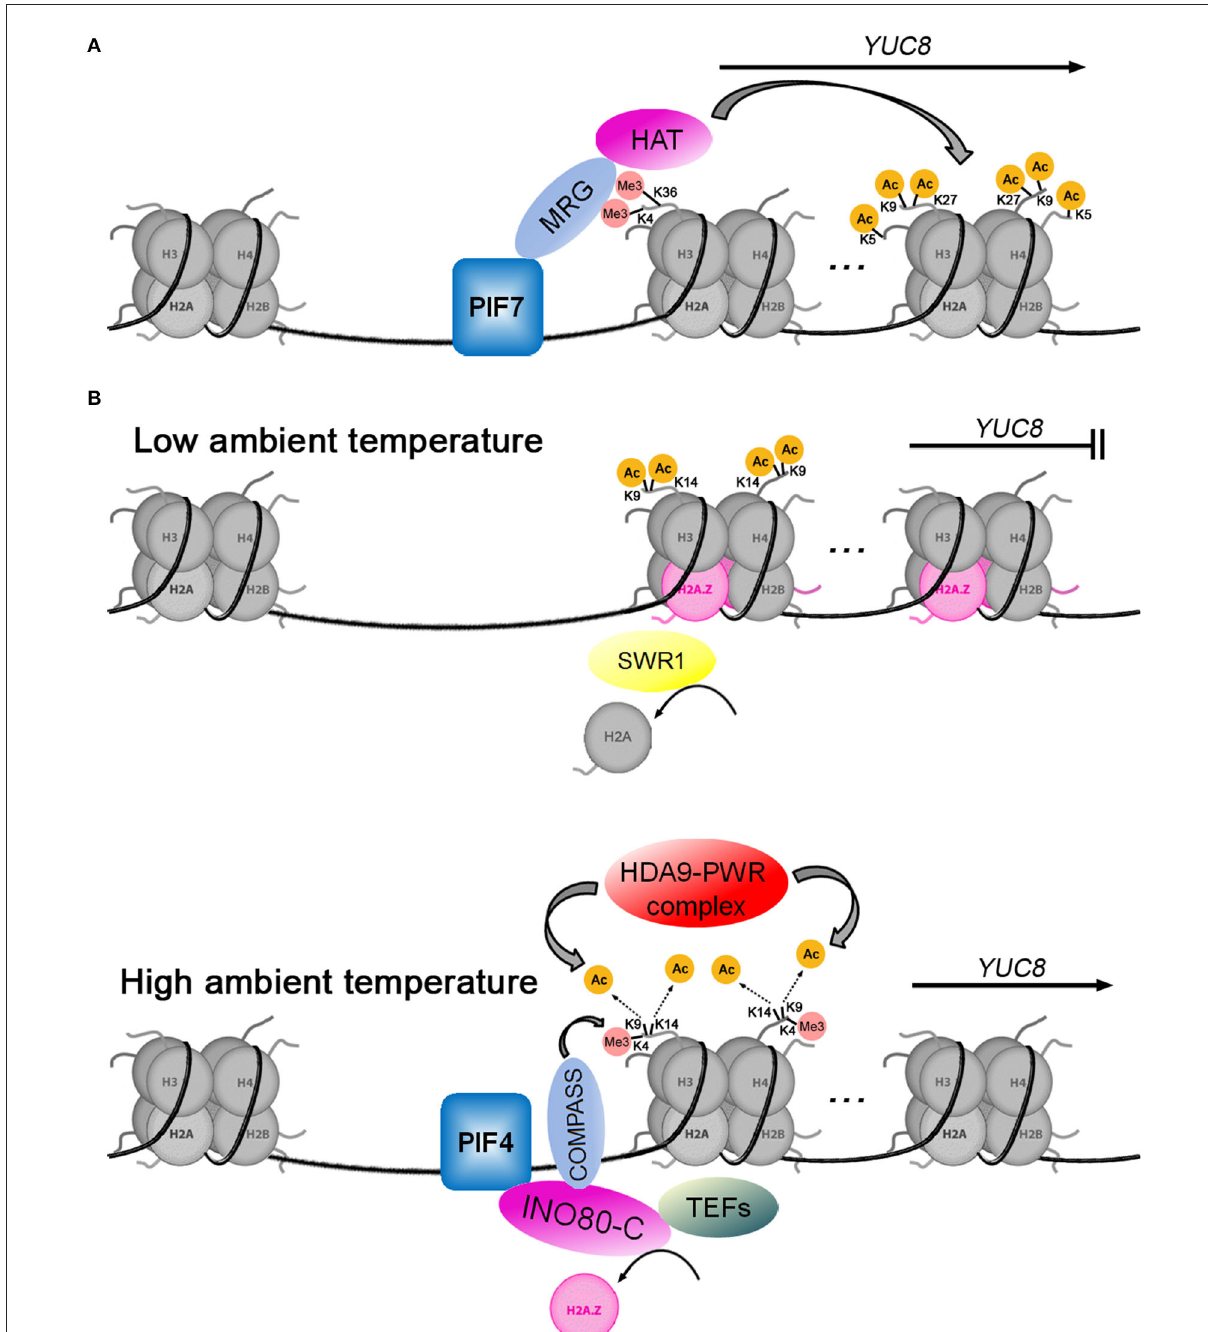
FIGURE3 Two models for histone acetylation involvement in transcriptional regulation of YUC 8. (A) The transcription factor PIF7 positively regulates YUC8 by recruiting the MRG-HAT complex. (B) When the ambient temperature rises, the HDA9-PWR complex mediates the deacetylation of H3K9 and H3K14, which opens YUC8 chromatin to allow PIF4 binding to activate YUC8 transcription. PIF4 recruits the INO80-C-COMPASS-TEFs complex to promote H2A.Z eviction, H3K4me3, and transcription elongation at the YUC8 loci.